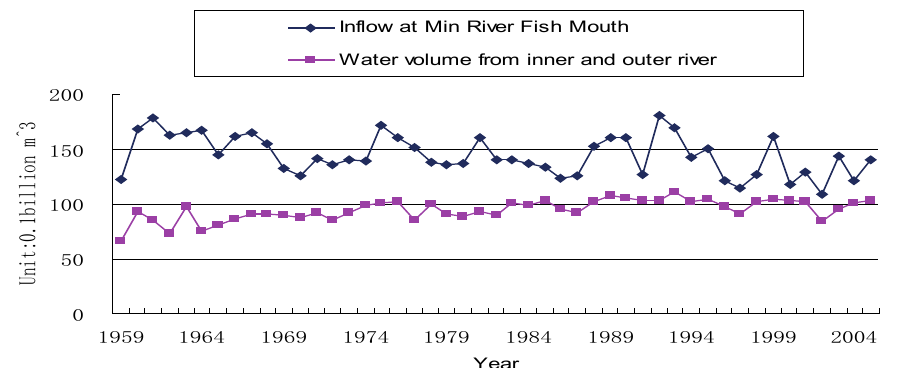
Fig. 4 Inflow at Min River Fish Mouth and water volume into Dujiangyan